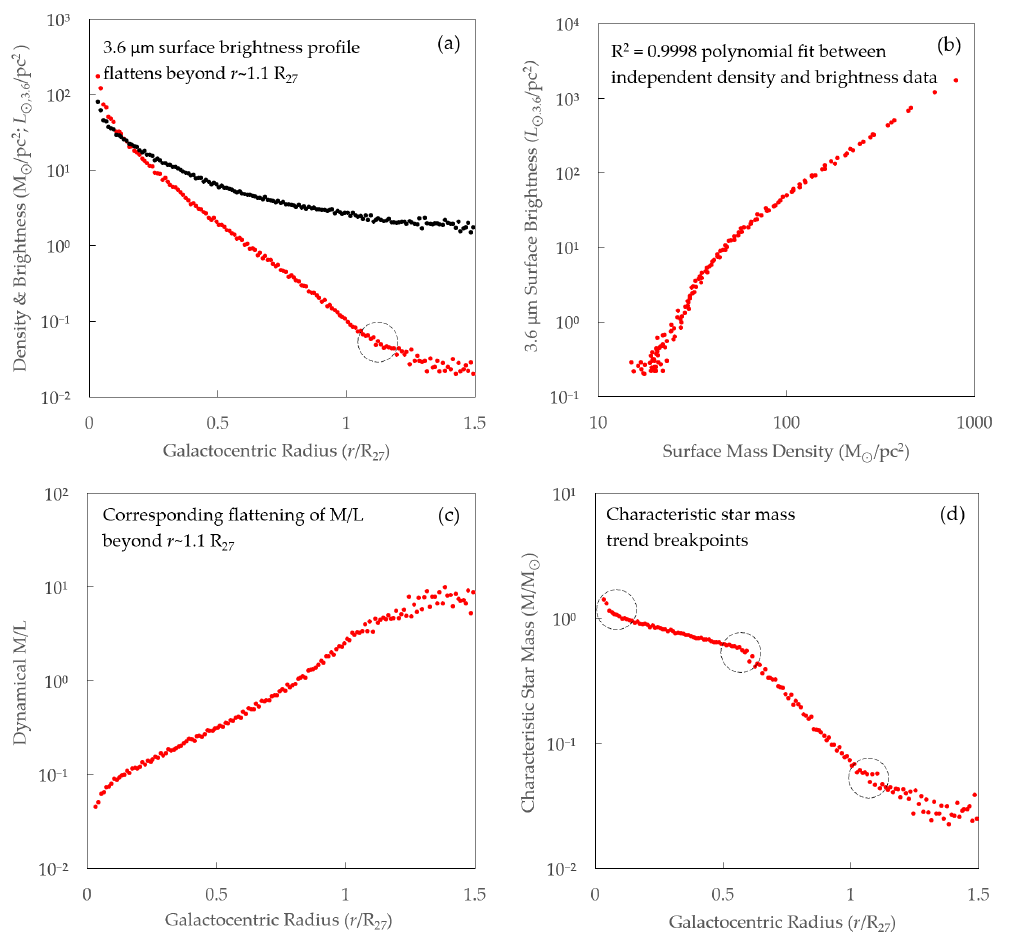
Figure 9. Sample-level radial trends in ( a ) surface mass density Σ ( r ), shown in black , and surface brightness S ( r ) shown in red ; ( b ) correlation between Σ ( r ) and S ( r ); ( c ) M / L ratio; ( d ) characteristic star mass profile. Each circle represents a mean average value across all datapoints of 214 galaxies, which fall into a radially corresponding bin of 0.01 R 27